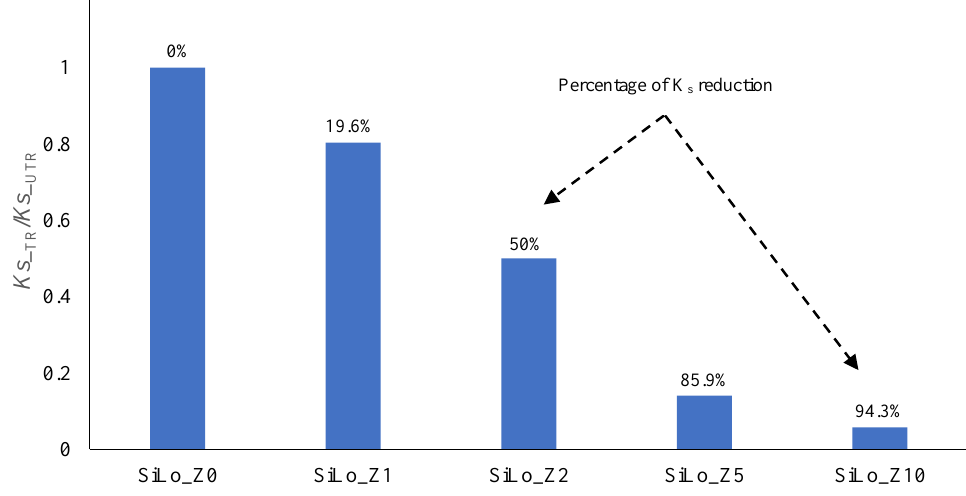
Figure 5. Effects of zeolite on soil hydraulic conductivity at saturation, K s , determined as the ratio between treated (TR) and untreated (UTR) soil samples. SiLo_Z0: soil without zeolite; SiLo_Z1: soil with 1% of zeolite; SiLo_Z2: soil with 2% of zeolite; SiLo_Z5: soil with 5% of zeolite; SiLo_Z10: soil with 10% of zeolite.